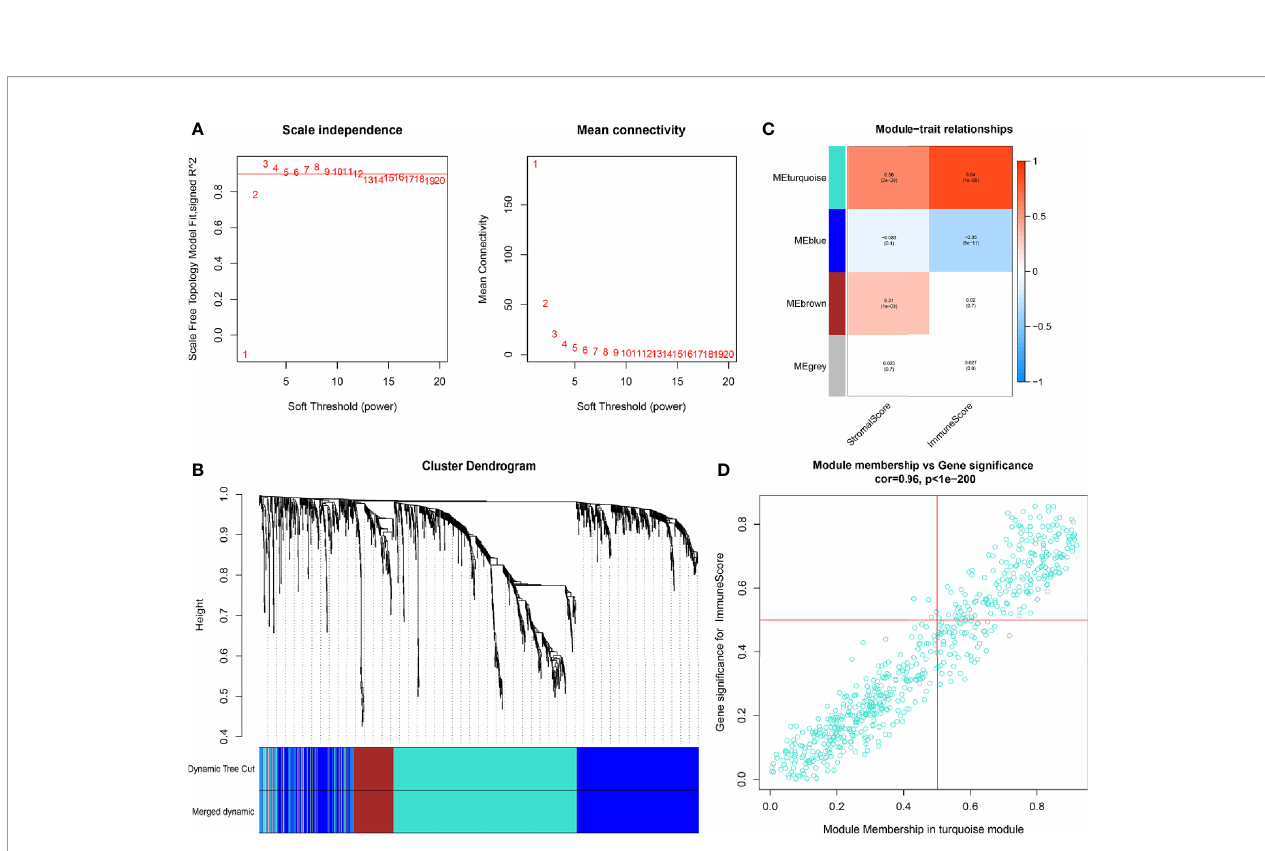
FIGURE 2 | (A) In order to achieve a scale-free co-expression network, we chose power index = 3 as the appropriate soft threshold. (B) Identi fi cation of a co- expression module. The branches of the dendrogram correspond to four different gene modules. (C) Correlation between the gene modules and tumor microenvironment related scores, including immune score and stromal score. Each cell contains corresponding correlation coef fi cient and p -value. The correlation coef fi cient decreased in size from red to blue. (D) Scatter plot of module eigengenes in the turquoise